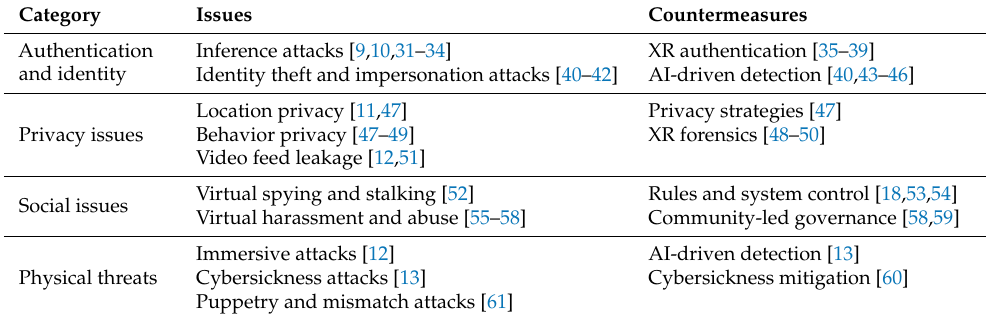
Table 2. An overview of visualization and cybersecurity issues and potential countermeasures. Category